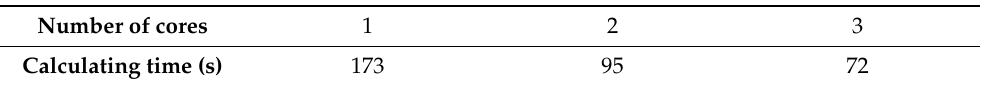
Table 4. Influence of number of cores used on calculation efficiency when running the SIMP- GA